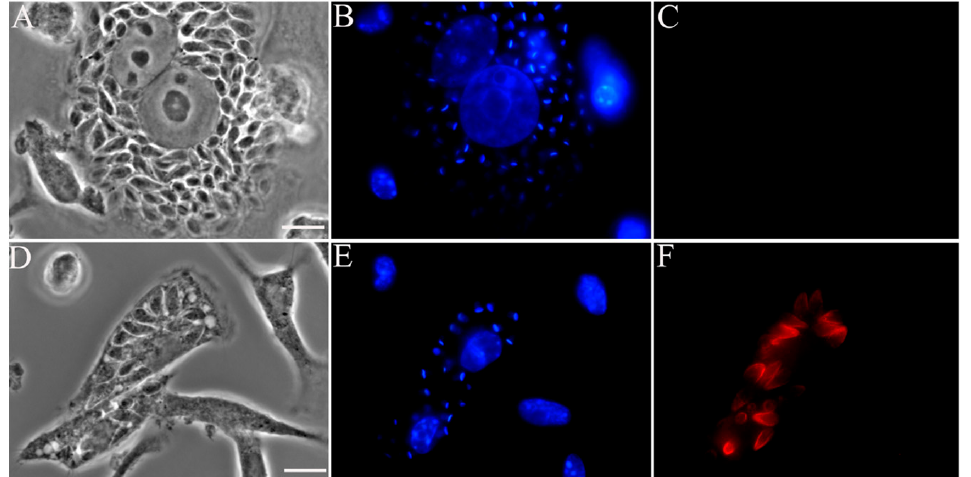
Figure 12. Immunofluorescence microscopy of T. cruzi amastigotes labelled with antibodies against LC3B (microtubule-associated protein light chain 3), an autophagic cell death marker (red), and DAPI, a nuclear marker (blue). A – C correspond to untreated cells and D – F represent cells treated with compound 27 (IC 50 ). The LC3 marking ( F ) indicates that intracellular amastigotes use the death-moving autophagy process. Bar = 10 μ m.